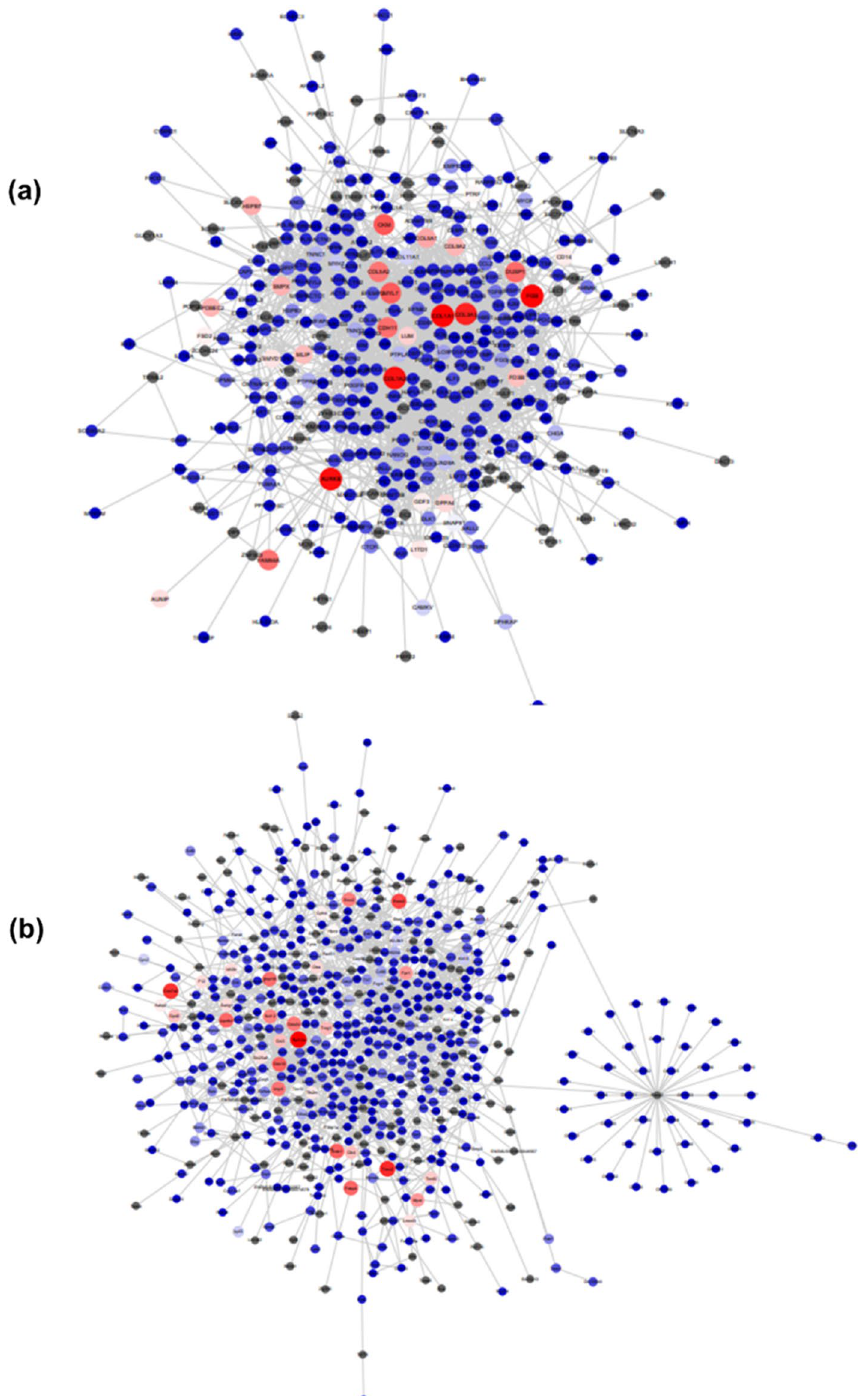
Fig. 4 The PPI networks of all the DEGs. They were edited in Cytoscape with continuous mapping so the colour and size of the node reflected the connection degree. This meant the redder, larger nodes represent a higher connection degree, while the bluer, smaller nodes represent a lower connection degree. For those DEGs, the maximum threshold for coexpression was set as 0.999 and the minimum threshold as 0.0, with values around 0.5019 coloured whiter. The top 10 nodes with the highest connection degrees are known as the hub genes in the PPI networks. a the human data set, GSE17579. b mouse data set,